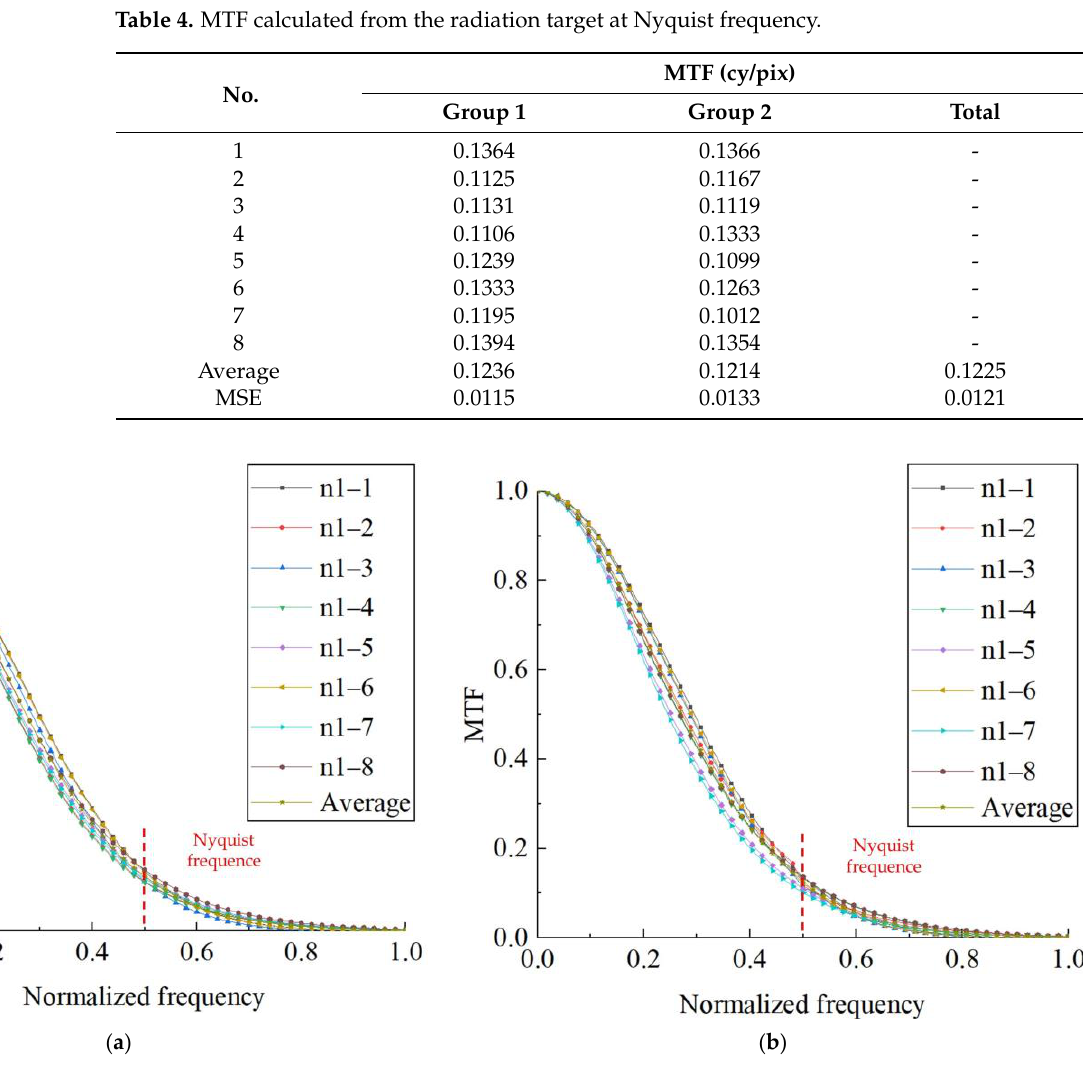
Figure 12. MTF calculated from the radiation target: ( a ) MTF calculated by the proposed algorithm